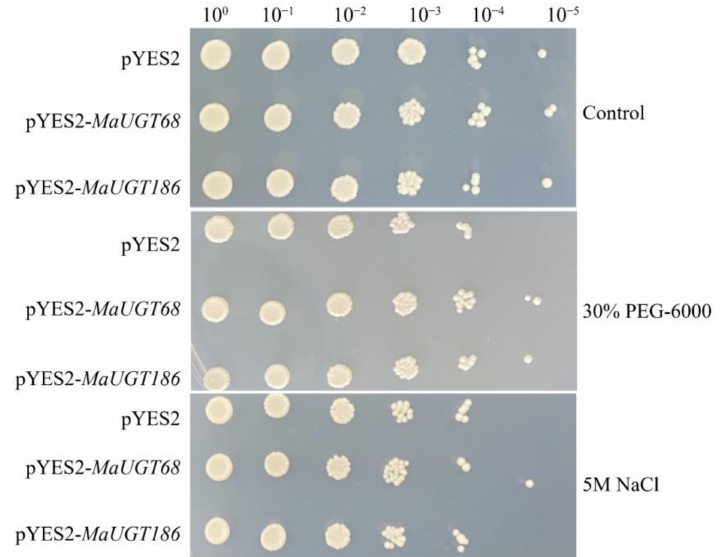
Figure 6. Abiotic stress tolerance analysis of MaUGT68 and MaUGT186 in a yeast expression system compared with empty pYES2 (control) yeast. The two yeast cultures were independently grown in synthetic complete (SC)-Ura liquid medium containing 2% ( m / v ) galactose at 30 ◦ C for 36 h up to A 600 = 0.4. Then, the yeast was collected and adjusted with SC-Ura including 2% galactose and cultivated up to A 600 = 1 for stress analysis. The same number of cells was resuspended in 30% PEG-6000 and 5 M NaCl. Then, serial dilutions (10 0 , 10 1 , 10 2 , 10 3 , 10 4 , 10 5 ) were spotted onto SC-Ura agar plates and incubated at 30 ◦ C for 3 days. As a control, yeast with A 600 = 1 without any stress was also spotted onto SC-Ura agar plates with the same dilutions as the treatments and grown at 30 ◦ C for 3